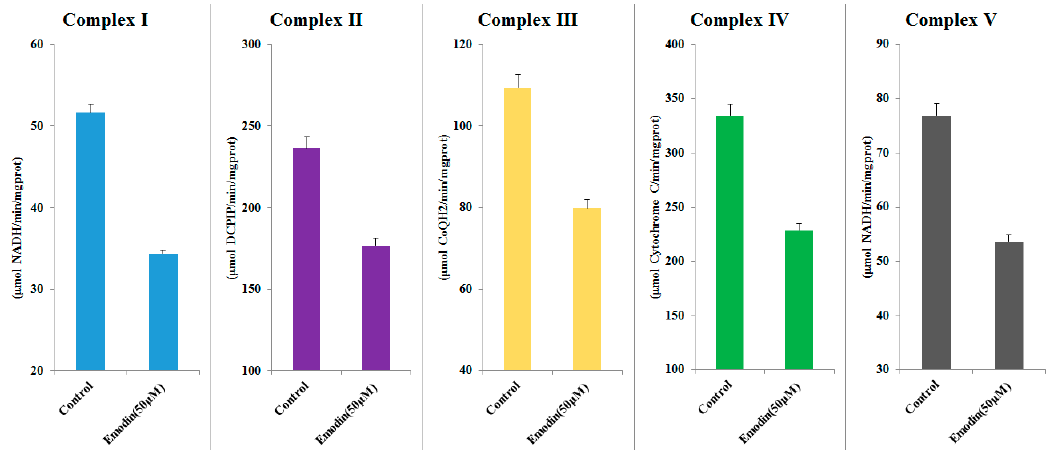
Figure 8. The results of mitochondrial respiratory chain complex activity assay (means ± SD, n = 3).